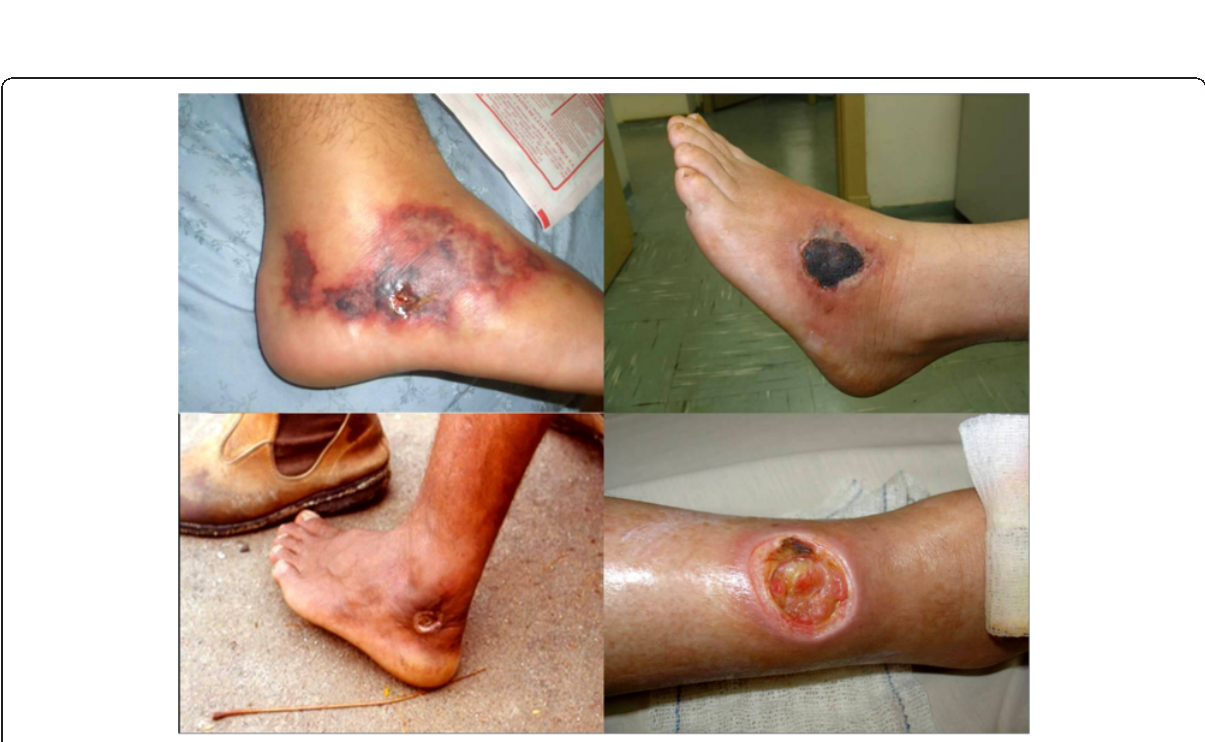
Figure 8 Extensive necrosis on the lower limbs of amateur and professional fishermen of the central regions of Brazil. Envenomations by freshwater stingrays tend to cause skin necrosis and chronic ulcers in the victim, who in most cases had stepped on the stingray in shallow waters. Photo by: Vidal Haddad